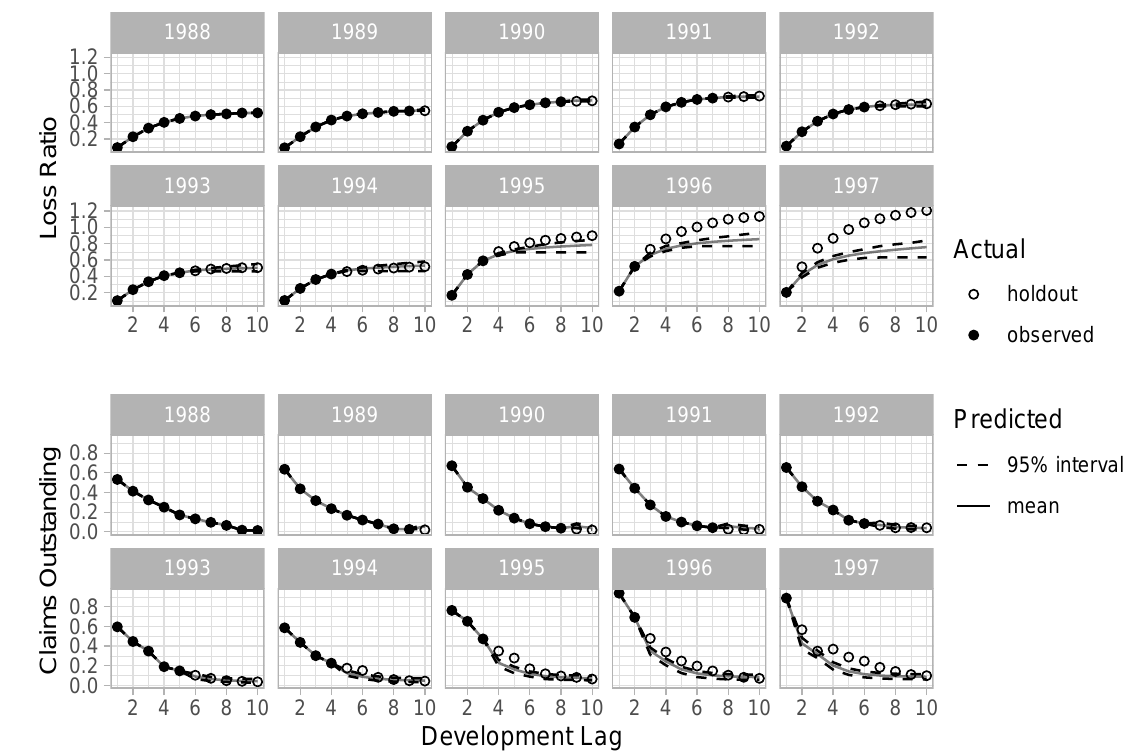
Figure 5. Development by accident year for Company 337, workers’